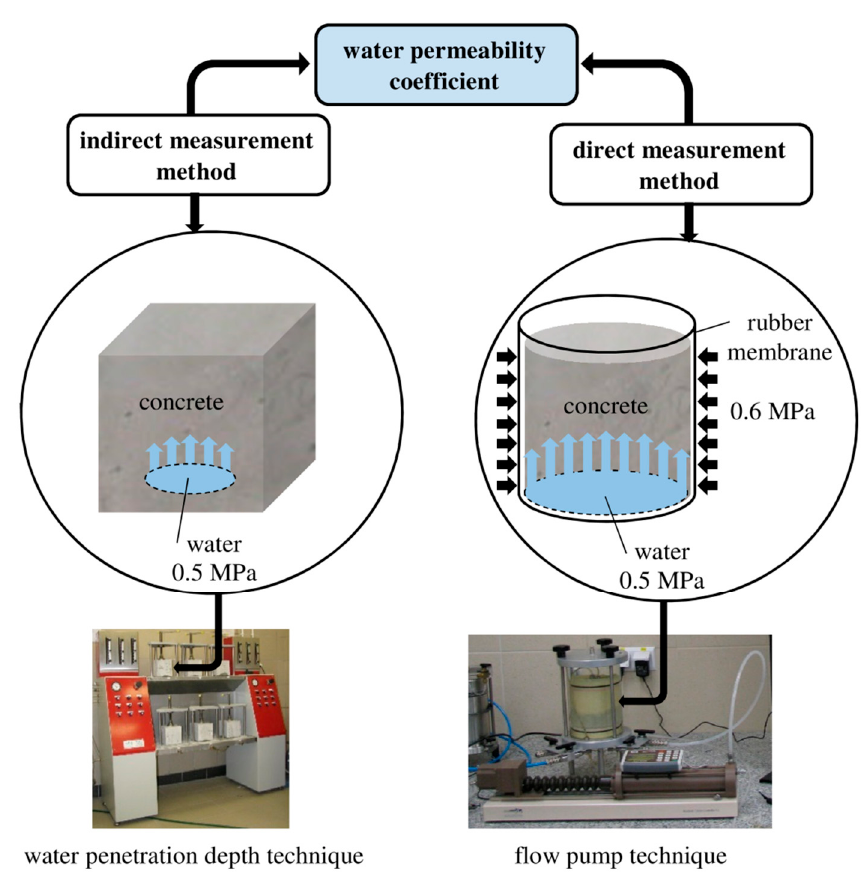
Figure 1. Scheme of the indirect and direct methods of testing the permeability coefficient.